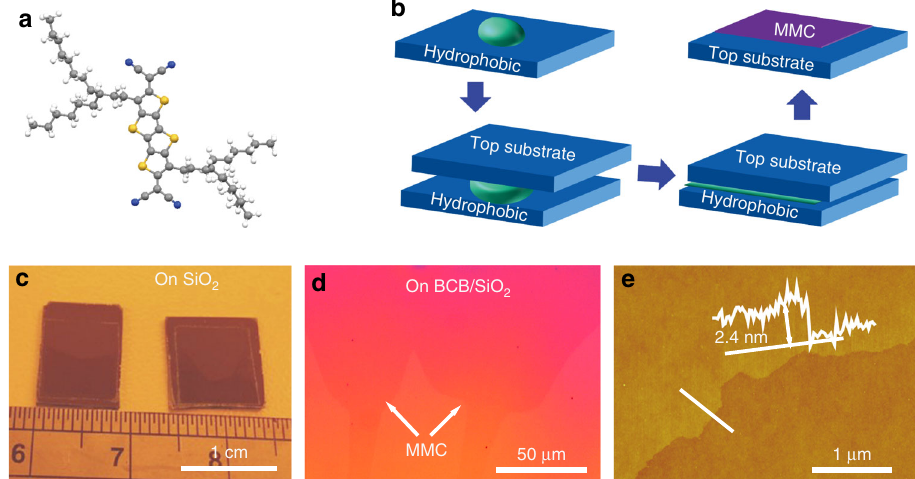
Fig. 1 Schematic of CMUT molecule structure and preparation process of MMCs. a Molecular structure of CMUT. Gray represents carbon atom, yellow represents sulfur atom, blue represents nitrogen atom, and white represents hydrogen atom. b Schematic illustration of preparation of the MMCs. The semiconductor solution was dropped onto an OTS-treated SiO 2 /Si substrate, and then a top substrate was placed atop. Finally we obtained crystalline monolayer fi lms on the top substrate after 24 h. c Large-area CMUT MMC up to centimeter size on SiO 2 /Si substrate. d Optical microscopy image and e corresponding AFM image of the MMC on BCB-treated SiO 2 /Si